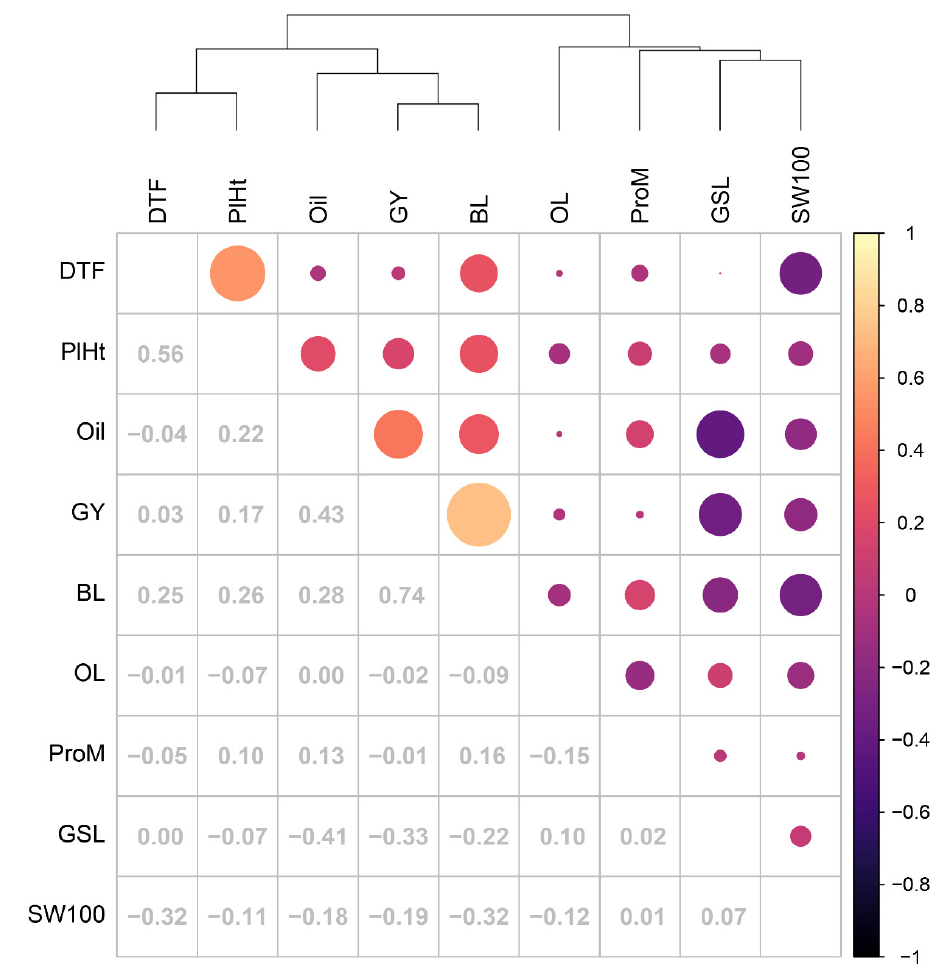
Figure 6. Cluster analysis of pair-wise correlations of predicted breeding values (PBV) derived from the optimum MMM-FA model of the genotype × environment effects for each trait. The traits correspond to grain yield (GY), days to 50% flower (DTF), plant height (PlHt), seed oil (Oil), protein in meal (ProM), glucosinolates (GSL), oleic acid (OL), phoma stem canker (blackleg) disease score (BL) and 100 seed weight (SW100). Correlation coefficients are shown as values below the diagonal and as circles above the diagonal, where the relative size and colour of circles represents the size and sign of the correlation coefficients as indicated by the colour code on the right-hand side.